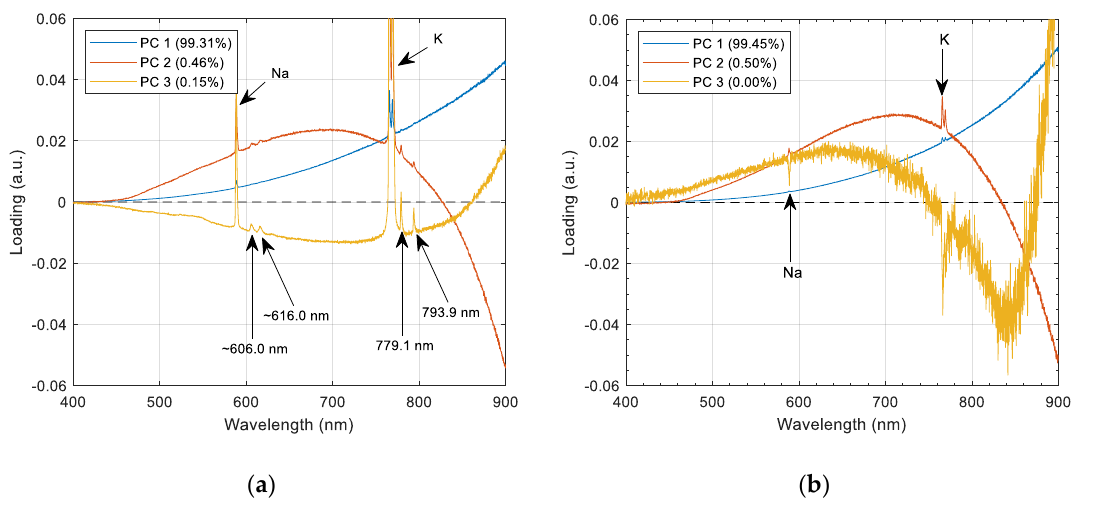
Figure 6. PCA loadings of the ( a ) Conc. A and ( b ) Conc. B average emission spectrum.